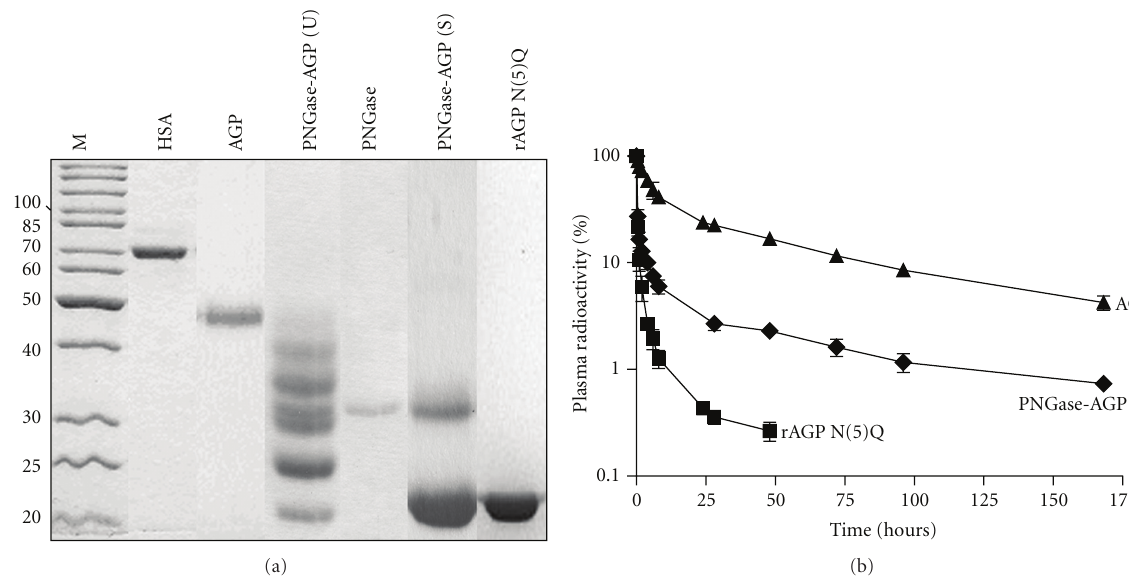
Figure 2: Forms of AGP with reduced or absent N-linked glycosylation are cleared from the rabbit circulation more rapidly than native AGP following intravenous injection. (a) Shows a Coomassie blue-stained 12% SDS reducing gel loaded with 5–10 μ g per lane of human serum albumin, HSA; AGP; AGP treated with PNGase F (PNGase) in the presence of either urea (PNGase-AGP (U) or SDS (PNGase-AGP (S); or recombinant yeast-derived nonglycosylated AGP (rAGP N(5)Q). (b) Depicts the residual acid-precipitable radioactivity remaining in the plasma of rabbits after intravenous injection of the indicated radiolabeled proteins as a function of time; for each protein, plasma radioactivity is presented as the percentage of the injected radioactive dose recovered in plasma at the indicated time after injection. Each point is the mean ± SD of 6 determinations; in most instances error bars are smaller than the symbol that denotes the